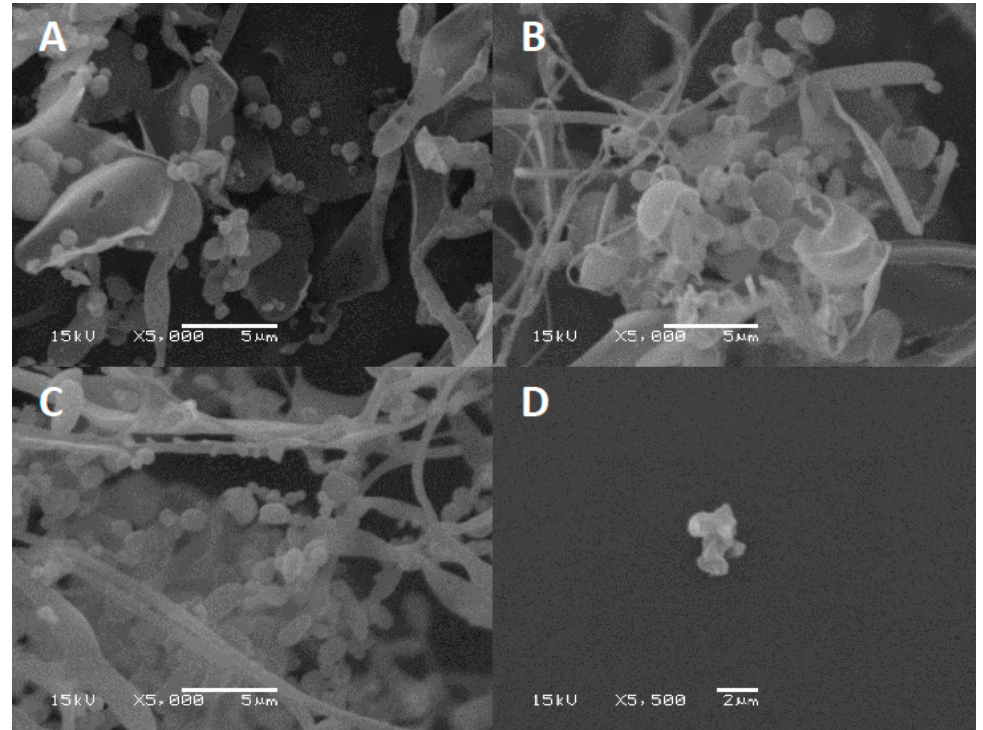
Figure 6. SEM of lyophilized phage CP30A. ( A ) Phage CP30A with tryptone imaged immediately after lyophilization. ( B ) Lyophilized phage CP30A with tryptone and incubated at 4 °C for 23 days. ( C ) Lyophilized phage CP30A with tryptone and incubated at 25 °C for 23 days. ( D ) Lyophilized phage CP30A without any addition. The scale bars are indicated in situ for each panel.